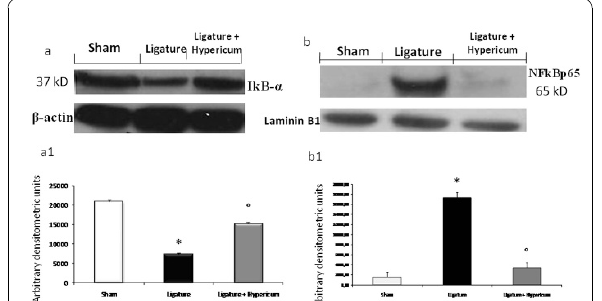
Figure 3 We evaluated I (cid:1) B- a degradation and nuclear NF- (cid:1) B p65 by Western Blot analysis . A basal level of I (cid:1) B- a was detected in the gingivomucosal tissue sections taken from the contralateral side (a, a1). I (cid:1) B- a levels were substantially reduced (a, a1.) in the gingivomucosal tissues from ligature operated rats. Hypericum treatment prevented I (cid:1) B- a degradation, (3a, a1). Periodontitis caused a significant increase in the NF-kB p65 levels in the gingivomucosal tissues from operated rats (b, b1). Hypericum treatment significantly prevented the periodontitis-mediated NF-kB p65 expression (b, b1).